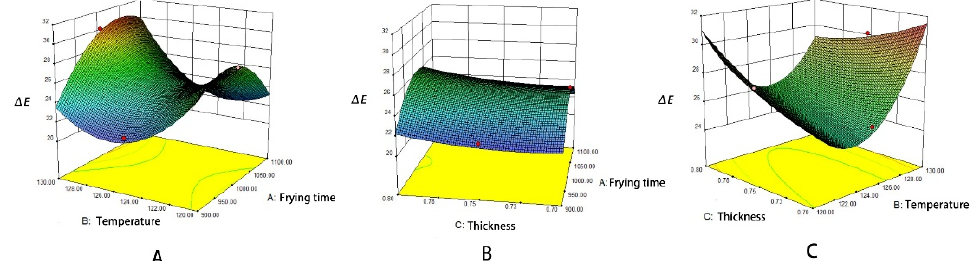
Figure 3. Response surface plots of interaction on color ( R 2 ). ( A ) Temperature-Frying time, ( B ) Thickness-Frying time, ( C ) Thickness- Temperature ( B ) Thickness-Frying time, ( C ) Thickness-